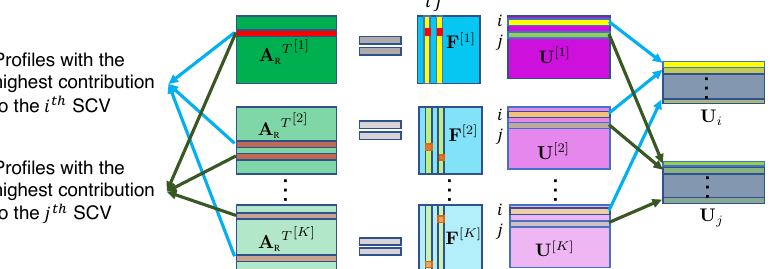
Figure 3. Identification of “one-to-many associations”. In the first modality, the indices of the largest absolute value of the coefficient in the i th column and the j th column of F [ 1 ] are the same, meaning that the same subject profile (marked in red) makes the highest contribution to the i th SCV and the j th SCV. This subject profile from the first modality is associated with the two subject profiles from the second modality and two subject profiles from the K th